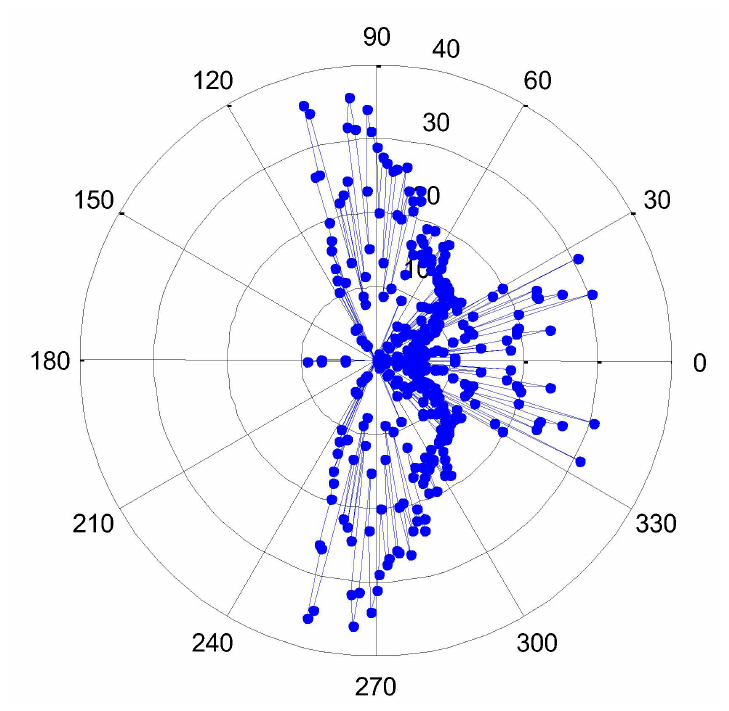
Figure 13. TS butterfly chart of the benchmark submarine.